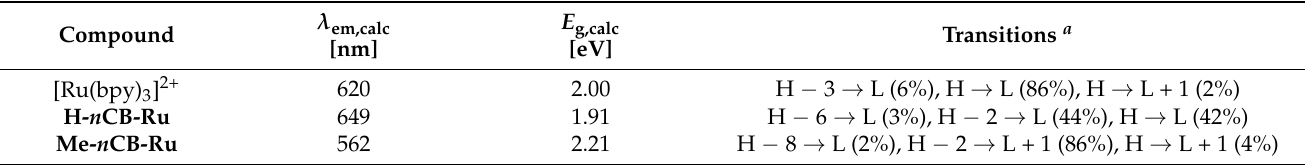
Table 5. Calculated emission data from TD-DFT at the optimized T 1 geometries.